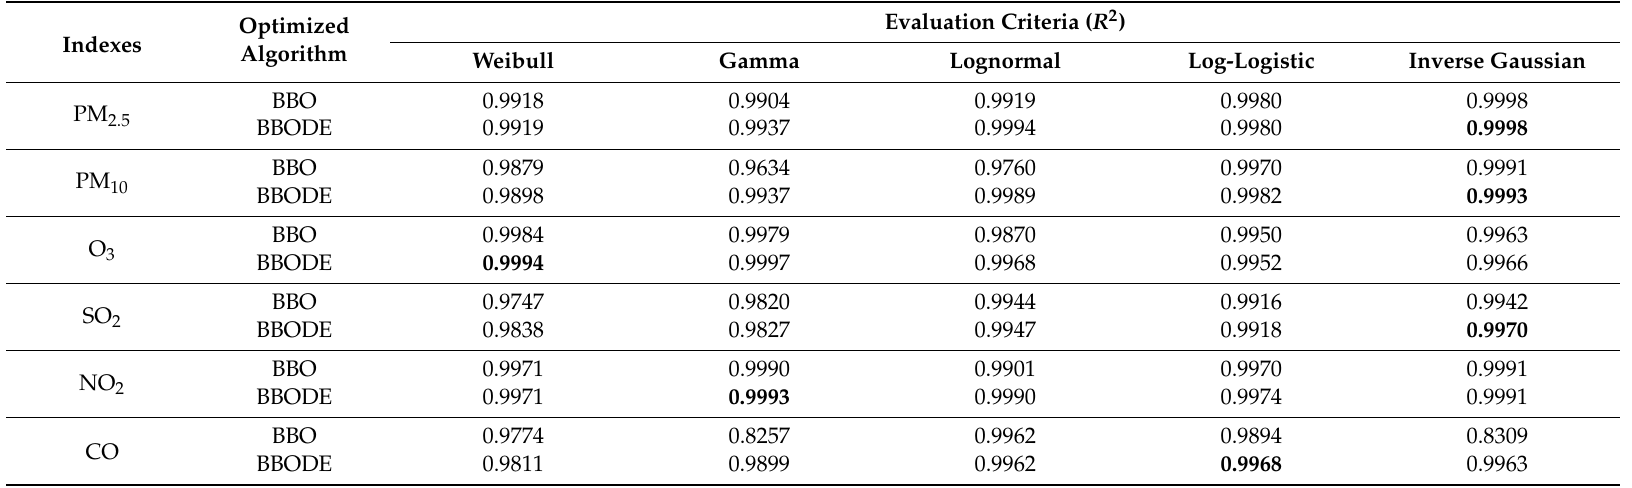
Table 6. R 2 of different distribution using different optimized algorithm. The data in bold denotes that it is largest in each line of Table 6, which represents the optimal R 2 of distribution